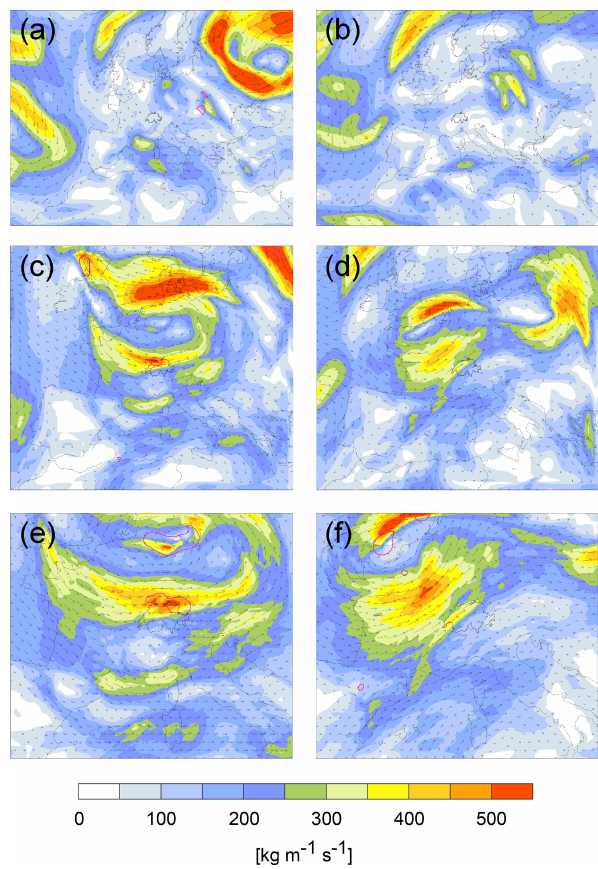
Figure 8. As in Fig. 6, but for 13 June 1876 00:00UTC, and for different maximum (#43) and minimum (#46)